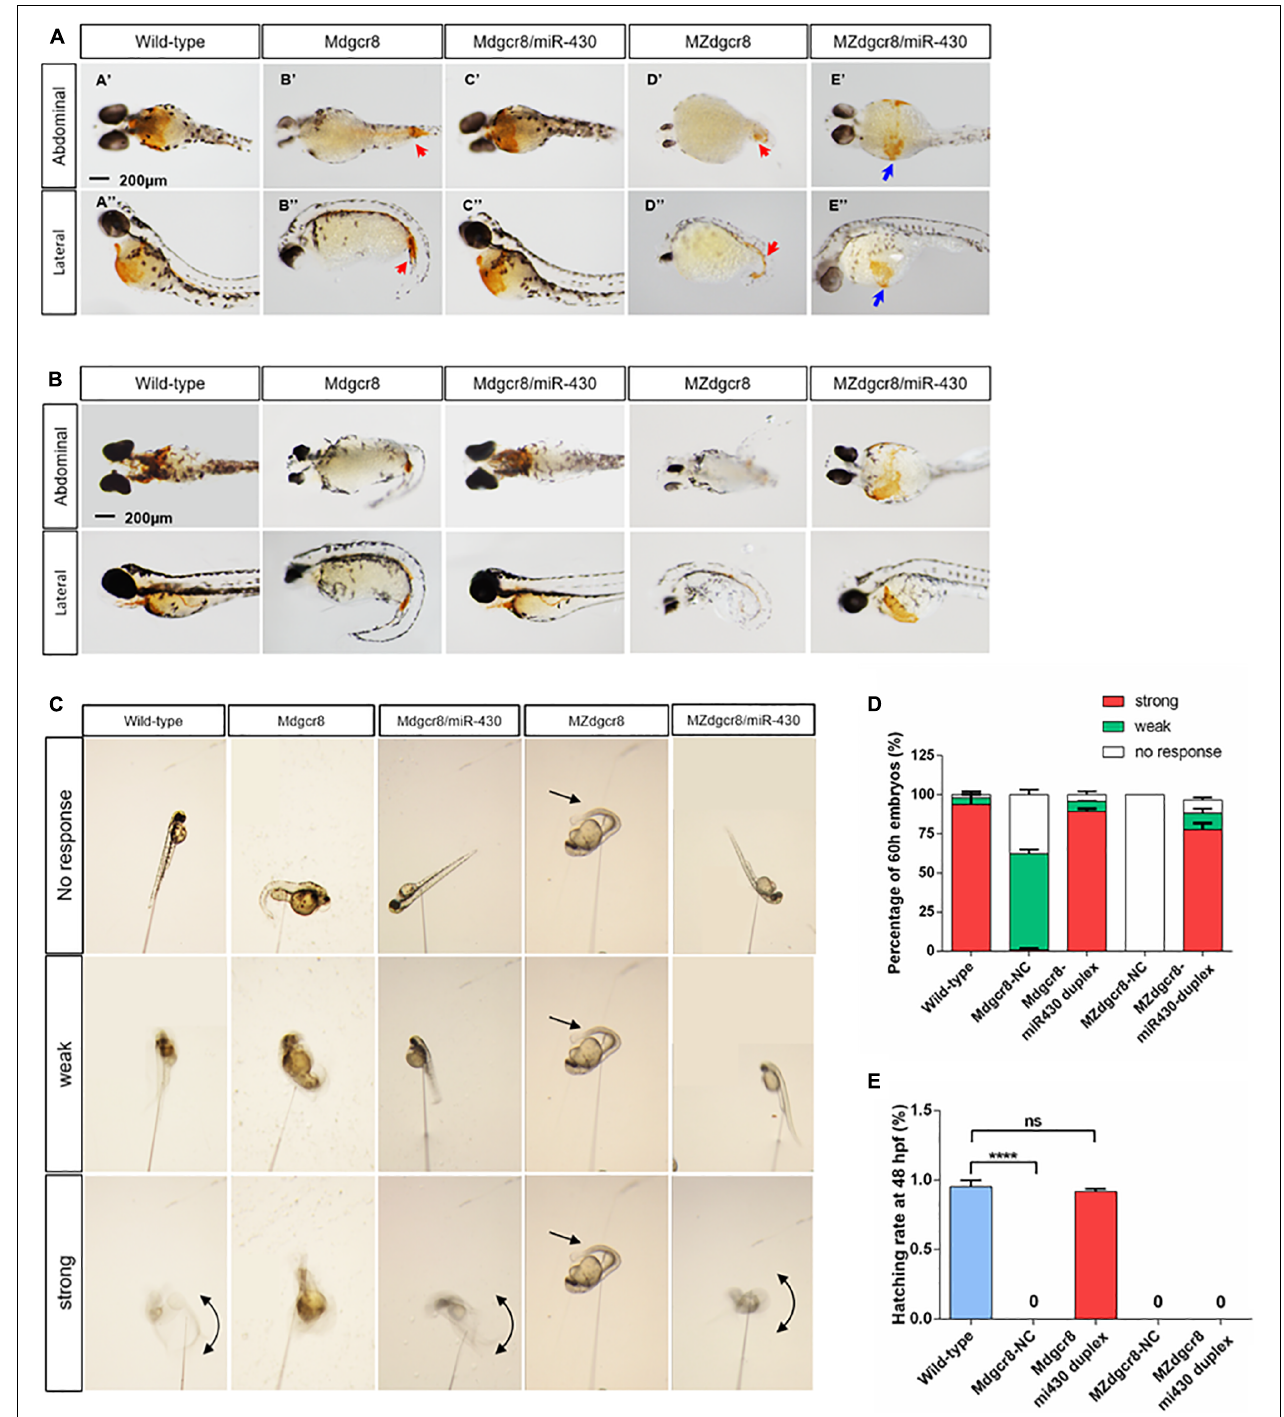
FIGURE 5 | Maternal mutants exhibit reduced erythropoiesis and could be rescued in M dgcr8 , but not in MZ dgcr8 . Whole embryo O-dianisidine staining assay was used for assessing functional hemoglobin in mature primitive erythrocytes in wild-type, M dgcr8 , MZ dgcr8 , and miR-430 rescued groups at 50 (A) and 74 hpf (B) . Hemoglobinized cells accumulate in the yolk sac in wild-type but mainly accumulate in the caudal vein (red arrows) in MZ dgcr8 and MZ dgcr8 mutants. 10–15 embryos per groups. Scale bar: 200 µ m. (C) The touch response was categorized as strong, weak, and no response based on the analysis of the video frames. (D) At 60 hpf, the rescue rate was determined in wild-type and maternal mutant embryos. (E) At 48 hpf, the hatching rate was detected in wild-type and maternal mutant embryos. **** p < 0.0001.